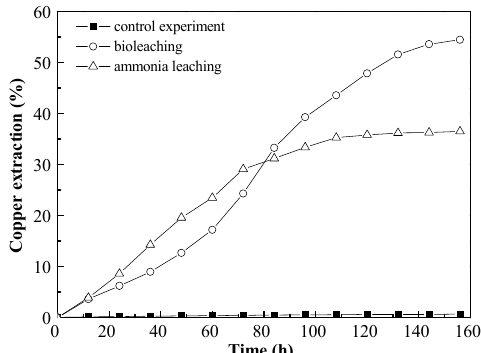
Figure 8. Comparison of bioleaching and chemical leaching at the pulp density of 1%. The initial ammonia concentration in chemical leaching was same with the concentration as those produced by strain in the absence of copper ore. Control experiment was carried out in urea medium without bacteria inoculation.